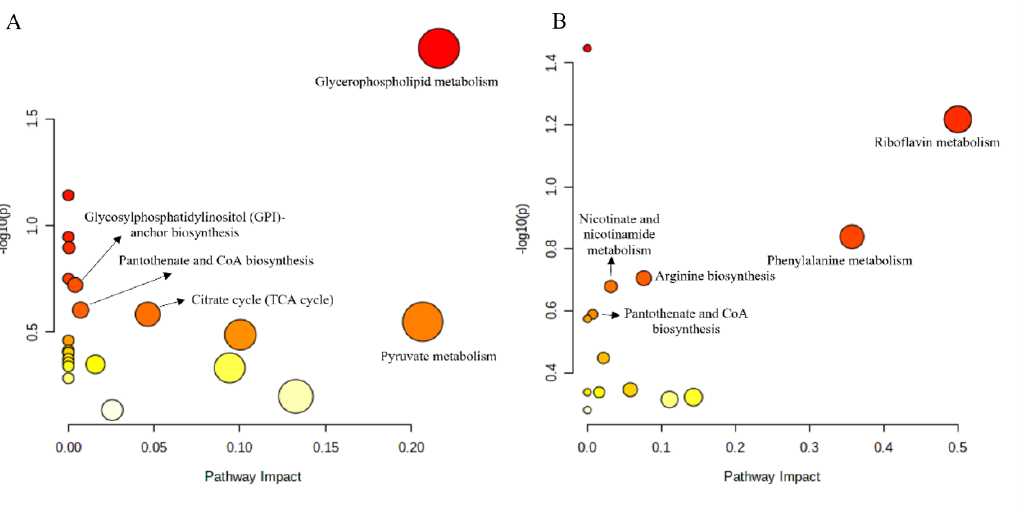
Figure 4. Volcano plots showing the differentially expressed metabolites among GM and CK groups ( A ) or among GI and CK groups ( B ). All metabolites presented in volcano plots were annotated through the KEGG database. Sig_Up, significantly up-regulated among control and treatment groups ( p < 0.05). Sig_Down, significantly down-regulated among control and treatment groups ( p < 0.05). NoDiff, no significant difference among control and treatment groups ( p > 0.05).